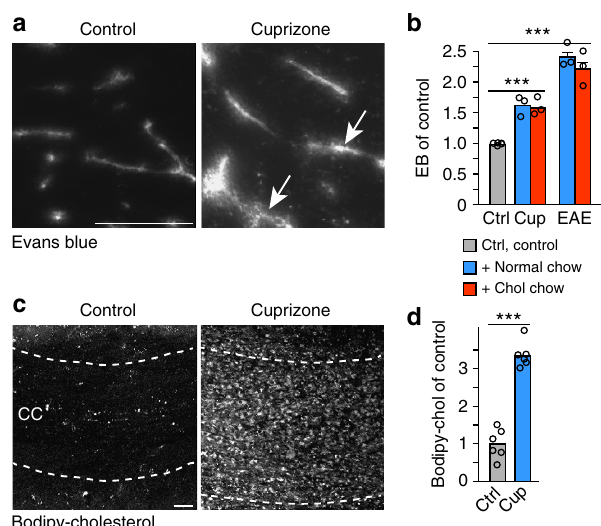
Figure 2 | Increased BBB permeability in cuprizone treated mice. ( a ) Extravasation of Evans blue on sections of the corpus callosum. In control animals, Evans blue fluorescence is restricted to blood vessels but extravasates in mice on cuprizone (arrows) (scale, 50 m m). ( b ) BBB permeability was measured by Evans blue (EB) extravasation in brains of animals fed cuprizone (cup) for 5 weeks on normal chow or cholesterol supplemented chow, or in brains of animals with EAE 2d after the peak of clinical symptoms ( n ¼ 3 animals). All treatment groups were normalized to untreated control animals ( n ¼ 5) and compared by one way ANOVA ( P o 0.0001). Nutritional cholesterol did not influence BBB permeability. Bars represent mean ± s.e.m. ( c ) Extravasation of bodipy-cholesterol. Maximum intensity projection of bodipy-cholesterol fluorescence in the corpus callosum (delineated by dashed lines) of mice that were kept on cuprizone for 5 weeks in comparison to untreated mice (control) (scale, 50 m m). ( d ) Quantification of bodipy-cholesterol extravasation after extraction. Data are expressed as fold changes ± s.e.m. in cuprizone treated mice compared with untreated control animals ( n ¼ 6 mice per group, unpaired Student’s t -test, P o